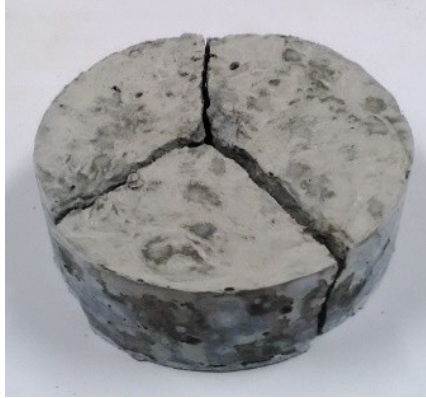
Figure 14. The fracture photo of the most specimen after impact test.